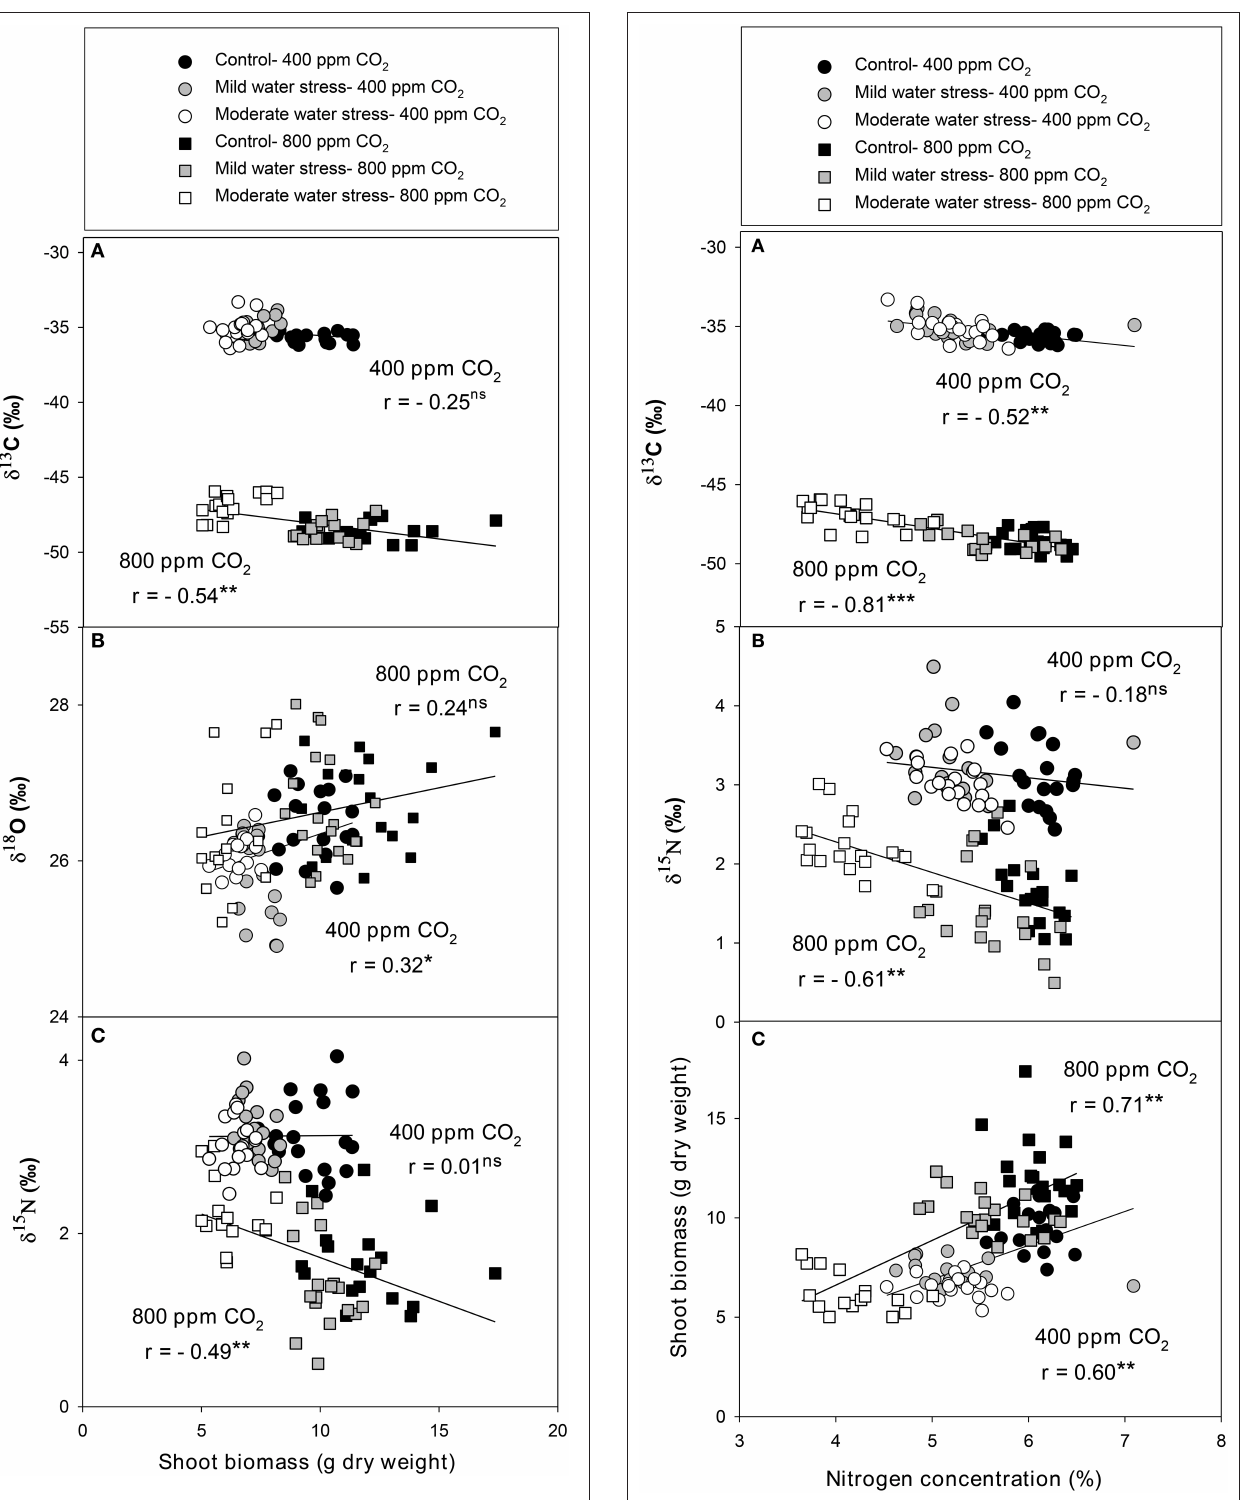
Frontiers in Plant Science | www.frontiersin.org